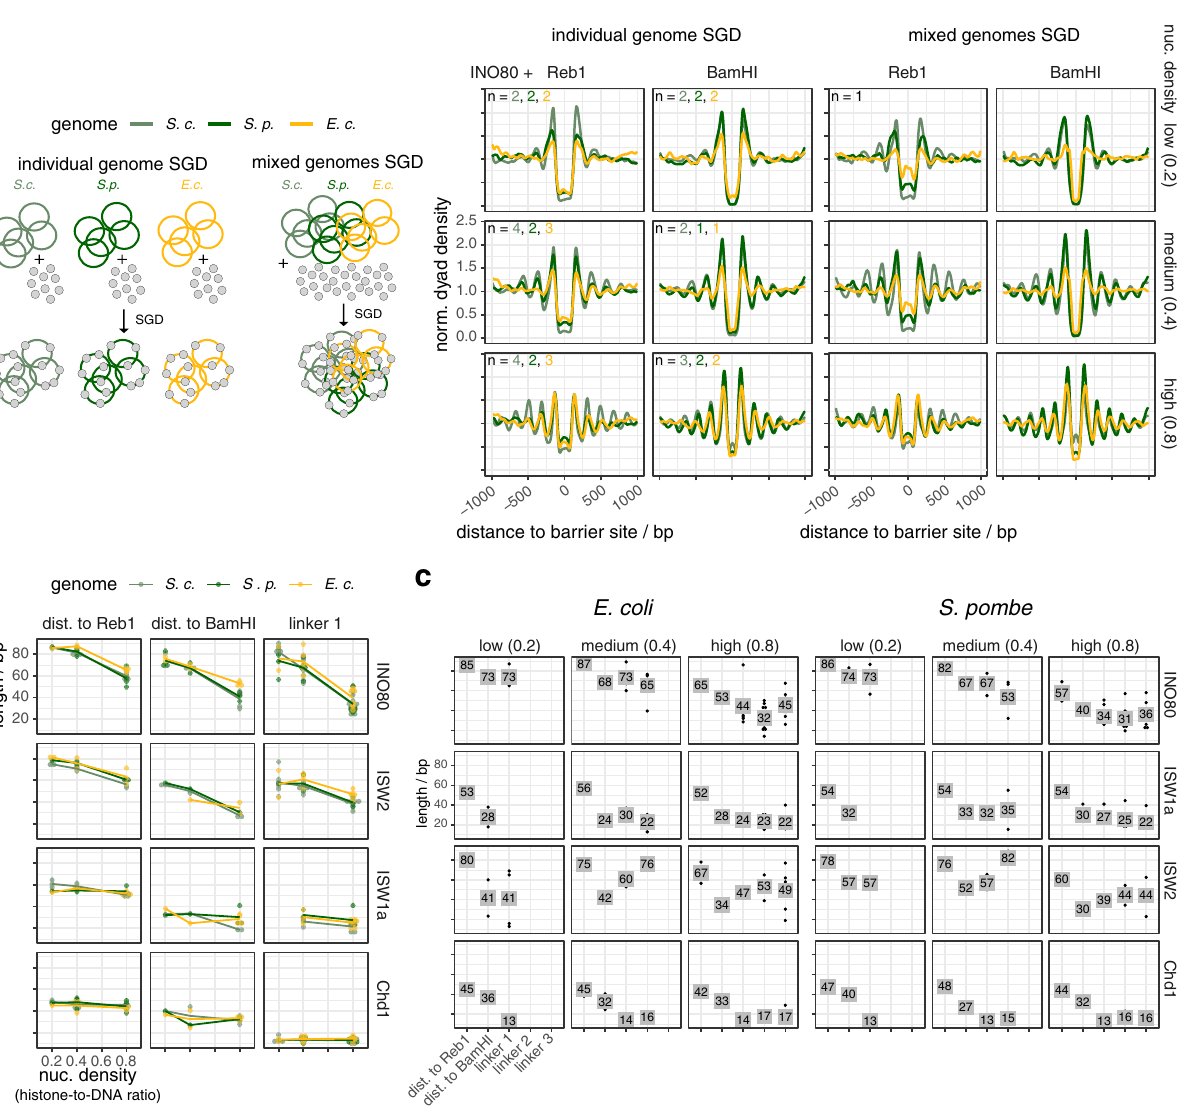
Fig. 3 Yeast remodelers generate arrays on heterologous genomes with same spacing and phasing distances as on the yeast genome. a Left: schematic similar to Fig. 1a showing SGD reconstitution with individual or mixed genomes. Right: composite plots of merged replicates as Fig. 2a but for the indicated barriers and either individual (left) or mixed (right, one replicate for each condition) genomes. Composite plots of individual replicates in Supplementary Fig. 4a. Reb1 sites were called by PWM. b , c As Fig. 2c, d, respectively, but for the indicated